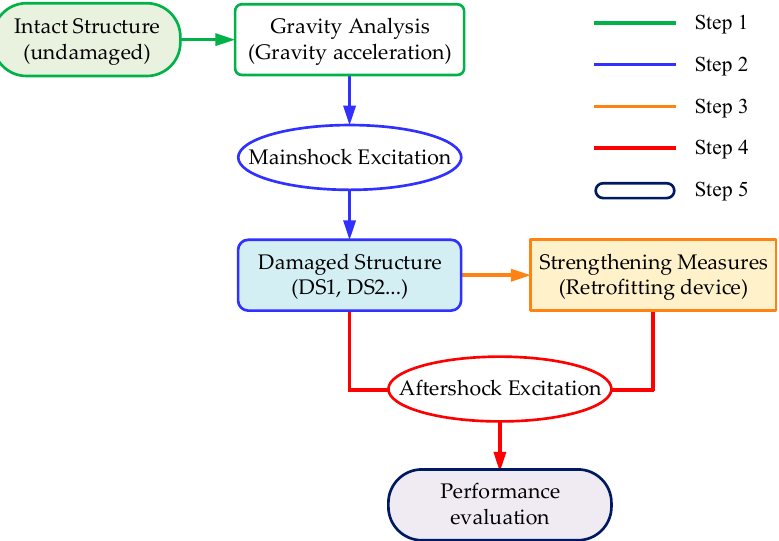
Figure 1. Post ‐ earthquake retrofitting evaluation framework of the mainshock ‐ damaged reinforced Figure 1. Post-earthquake retrofitting evaluation framework of the mainshock-damaged reinforced concrete (MD ‐ RC) frames. concrete (MD-RC)